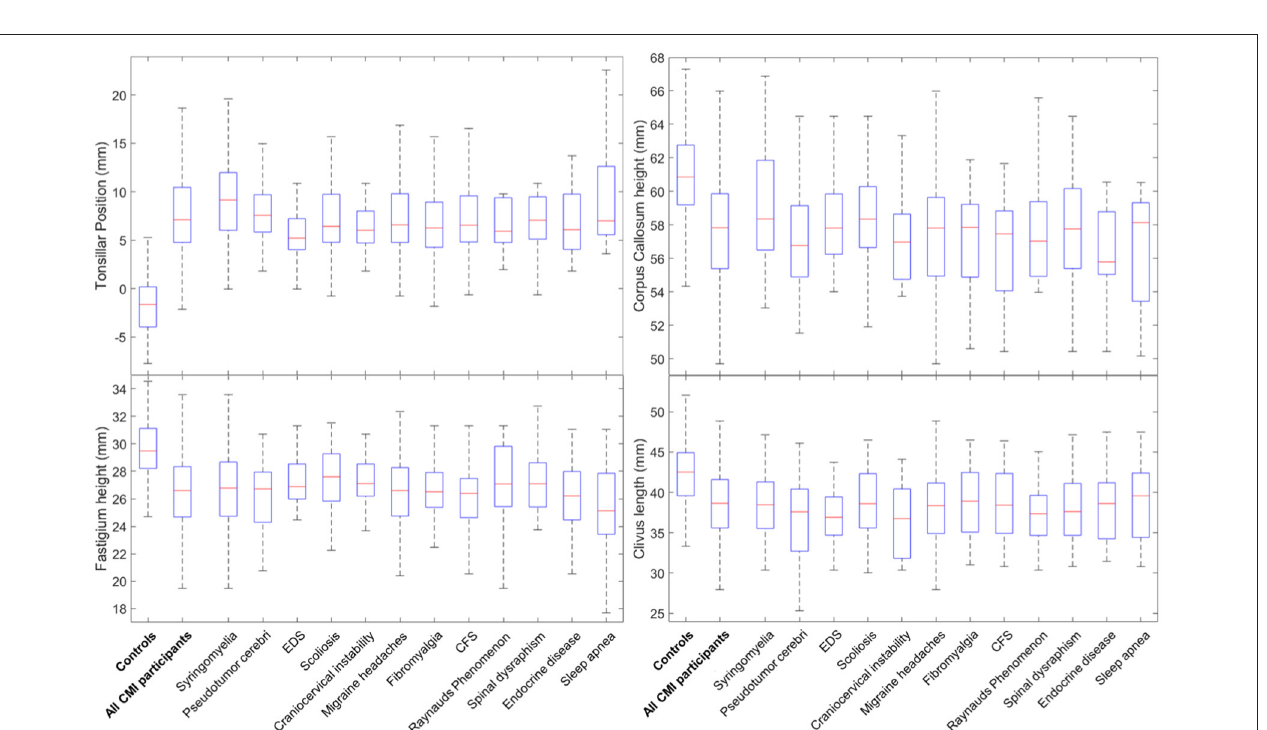
in CMI participants with migraine headaches. CMI participants with migraine headaches demonstrated angular differences including a wider basal and Boogard angle, and a narrower Wackenheim and odontoid angle. Intracranial measurements reflected a significantly smaller intracranial height and area in CMI participants with migraine headaches compared to controls.